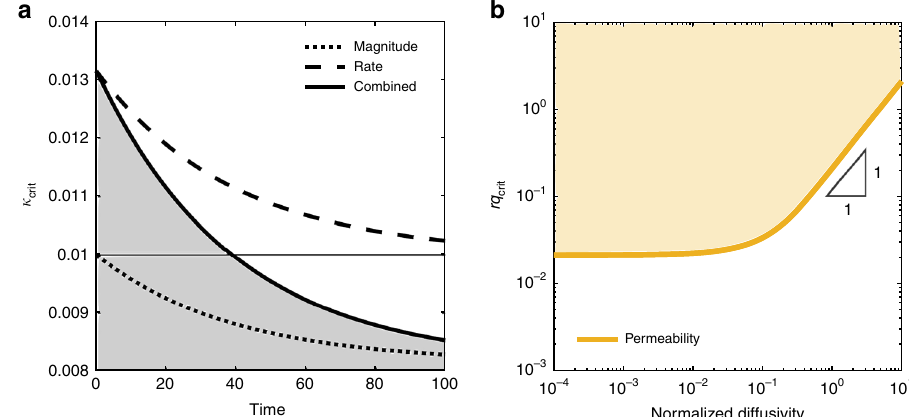
Fig. 2 Dimensionless critical stiffness and critical injection rate. a Critical stiffness − below which stick-slip instability is triggered ( κ < κ crit ) and above which stick-slip instability is inhibited ( κ > κ crit ) − in response to fl uid injection at constant rate in velocity-weakening material ( c = 3 × 10 − 2 , rq = 5 × 10 − 3 ). The combined effect is illustrated by the solid curve, which shows a transition in the effect of fl uid injection from de-stabilizing at early times to stabilizing at late times. The effect of the magnitude of pore pressure is illustrated by the dotted curve. The effect of the rate of change in pore pressure is illustrated by the dashed curve. b Critical injection rate − above which stick-slip instability is triggered − as a function of the normalized diffusivity of the system. The diffusivity is varied by varying permeability (beige curve in b